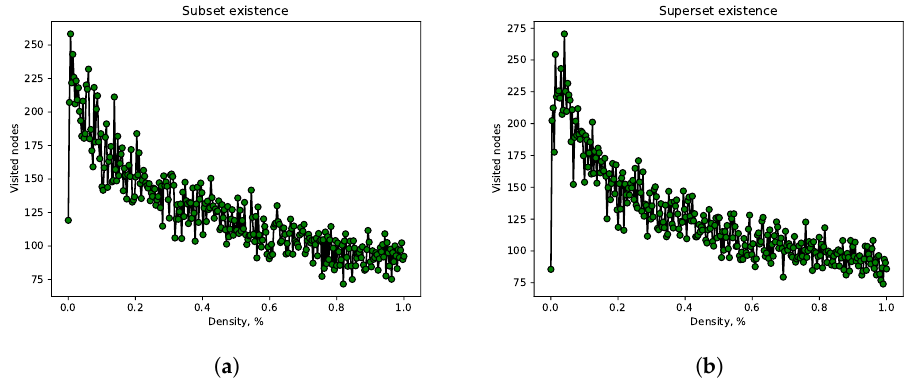
Figure 8. Existence functions in Experiment 3. ( a ) submsetExistence; ( b )